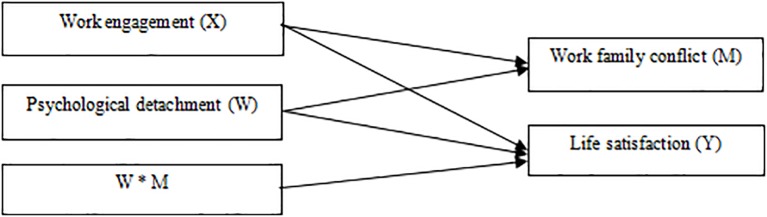
A moderated mediating model.